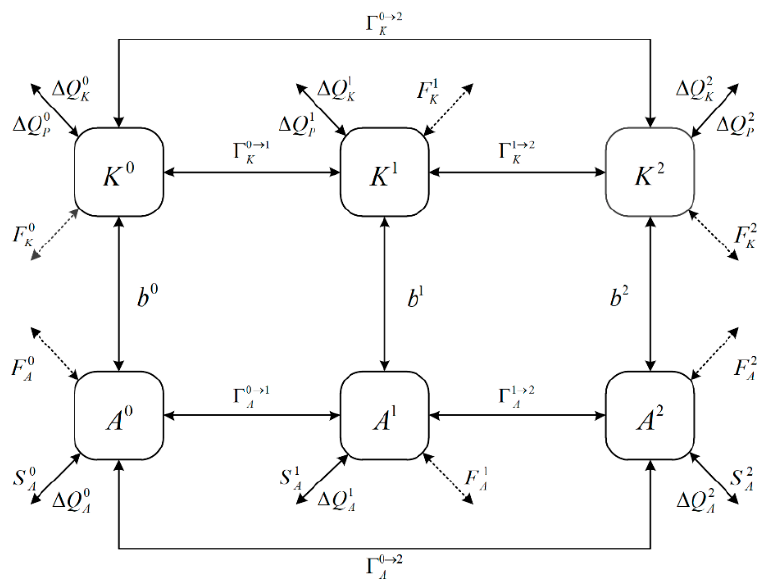
Figure 2. The energy diagram based on three-window decomposition. The solid arrows in both directions represent the energy transport and transfer terms, while the dashed arrows represent the energy dissipation terms.